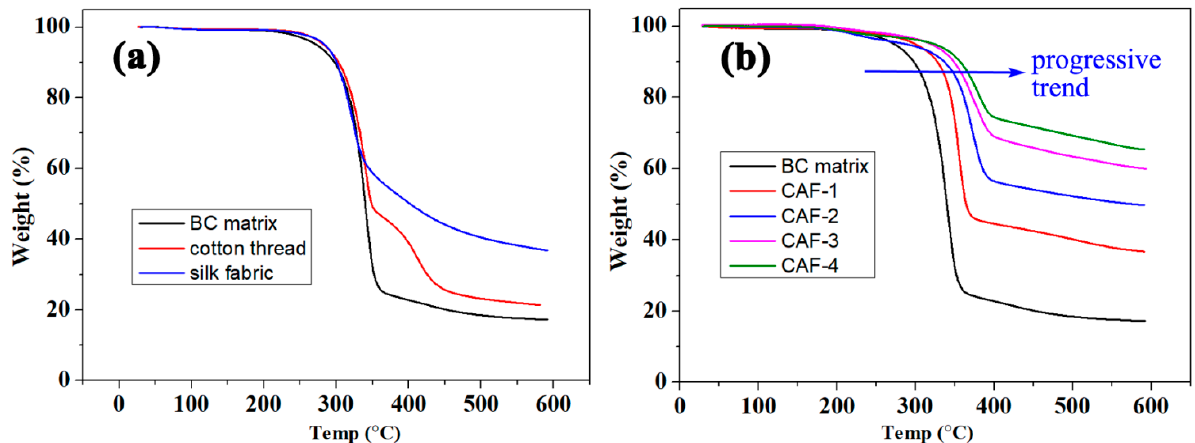
Figure 7. ( a ) Thermogravimetry analysis (TGA, 10 °C min − 1 heating) curves of BC matrix, cotton thread, and silk fabric. ( b ) Thermogravimetry analysis (TGA, 10 °C min − 1 heating) curves of BC matrix and CAFs. The blue arrow shows the temper- ature changes of each material at the same change in weight proportion (88%).